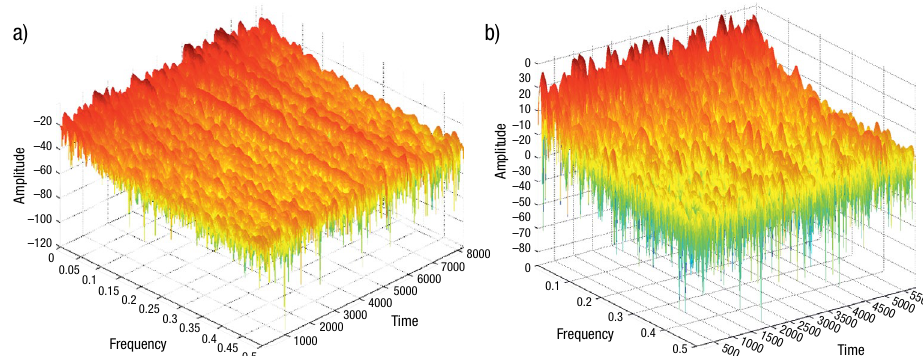
Fig. 18. Bund Futures 1 min – price series spectrogram (a), 5 min – price series spectrogram (b), Signal Processing Toolbox